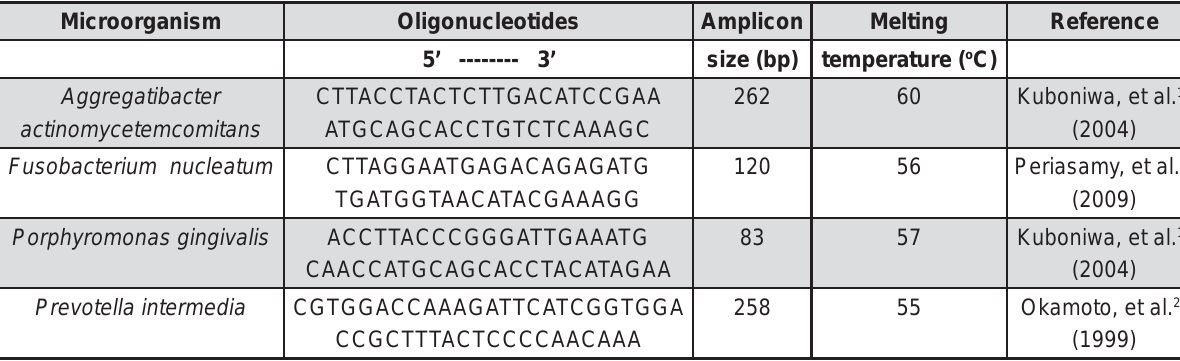
Figure 1- (cid:3)(cid:54)(cid:83)(cid:72)(cid:70)(cid:76)(cid:72)(cid:86)(cid:16)(cid:86)(cid:83)(cid:72)(cid:70)(cid:76)(cid:191)(cid:70)(cid:3)(cid:82)(cid:79)(cid:76)(cid:74)(cid:82)(cid:81)(cid:88)(cid:70)(cid:79)(cid:72)(cid:82)(cid:87)(cid:76)(cid:71)(cid:72)(cid:86)(cid:3)(cid:88)(cid:86)(cid:72)(cid:71)(cid:3)(cid:73)(cid:82)(cid:85)(cid:3)(cid:87)(cid:75)(cid:72)(cid:3)(cid:84)(cid:88)(cid:68)(cid:81)(cid:87)(cid:76)(cid:87)(cid:68)(cid:87)(cid:76)(cid:89)(cid:72)(cid:3)(cid:71)(cid:72)(cid:87)(cid:72)(cid:70)(cid:87)(cid:76)(cid:82)(cid:81)